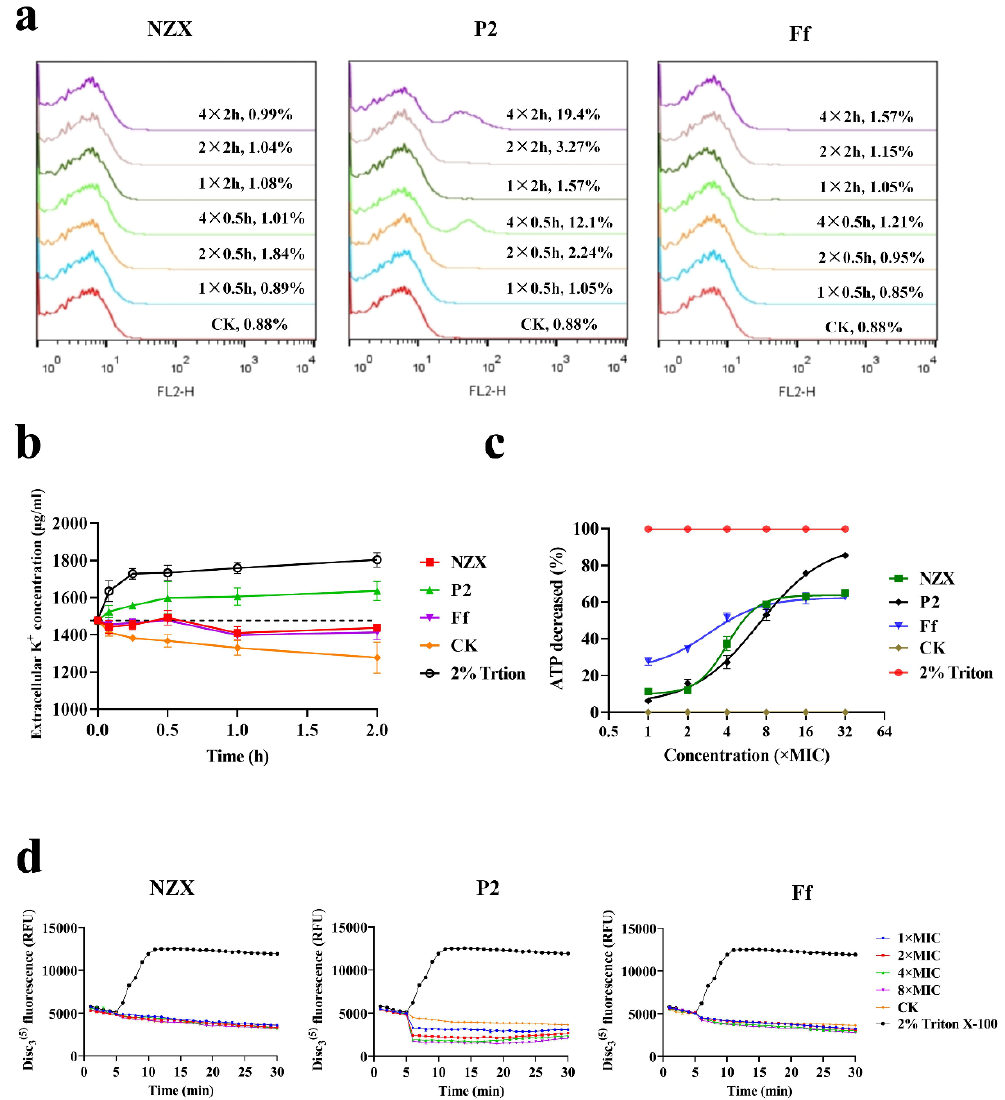
Figure 2. Effects of NZX and P2 on the cell membrane: ( a ) Effects of NZX and P2 on integrity of S. agalactiae ACCC 61733 cells membrane. The membrane penetration rates of NZX and P2 to S. agalactiae cells were detected by flow cytometer under the concentration of 1 × , 2 × , and 4 × MIC for 30 min and 2 h, respectively. ( b ) Changes in the concentration of extracellular K + of S. agalactiae ACCC 61733 cells caused by NZX and P2. The concentration of extracellular K + of S. agalactiae was detected by atomic absorption spectrometer under treatment with 5 × MIC NZX and P2 for 0–2 h, respectively. ( c ) ATP release of S. agalactiae ACCC 61733 cells caused by NZX and P2. ATP content of S. agalactiae cells was measured using a multifunctional microplate reader after treatment with 1–16 × MIC NZX and P2 for 1 h, respectively. ( d ) Changes of membrane potential of S. agalactiae ACCC 61733 cells caused by NZX and P2. Membrane potential of S. agalactiae ACCC 61733 cells was determined by multifunctional microplate reader under the concentration of 0.5–8 × MIC NZX and P2 for 30 min. CK was the untreated